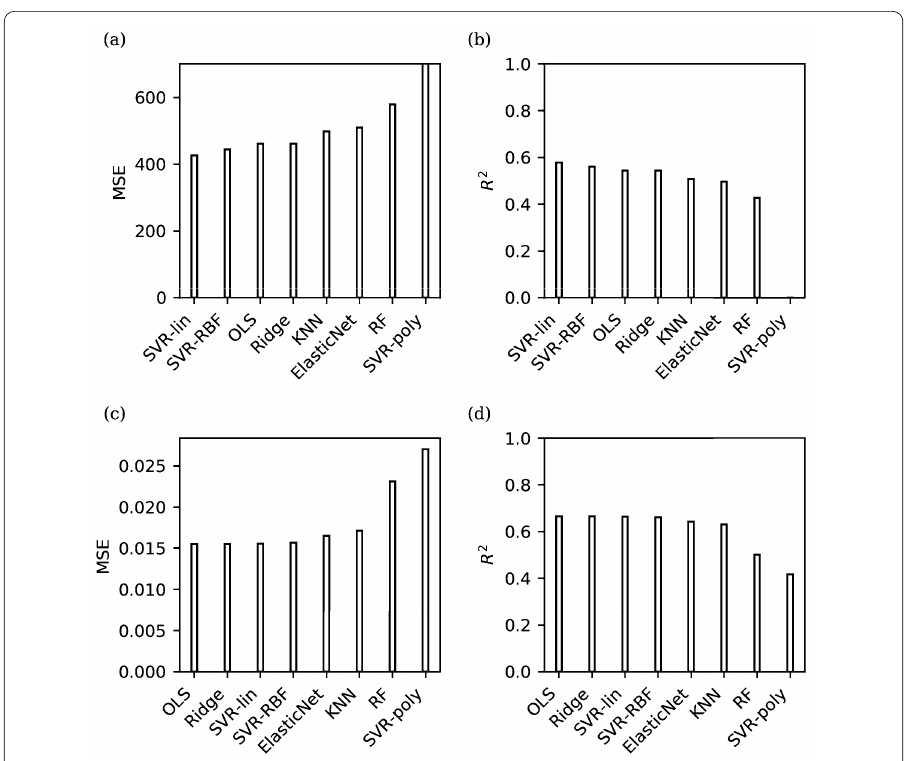
Figure 5 Regression metrics. These are the MSE and R 2 values for predicting the post-move means of the number of calls (( a ) and ( b )) and the fraction of calls (( c ) and ( d )) using the log-transformed pre-move counts (( a ) and ( b )) and the pre-move fractions (( c ) and ( d )). The R 2 for the SVR with a polynomial kernel in predicting the post-move counts is negative, while the corresponding MSE (1.3 × 10 7 ) is much higher than the MSE of